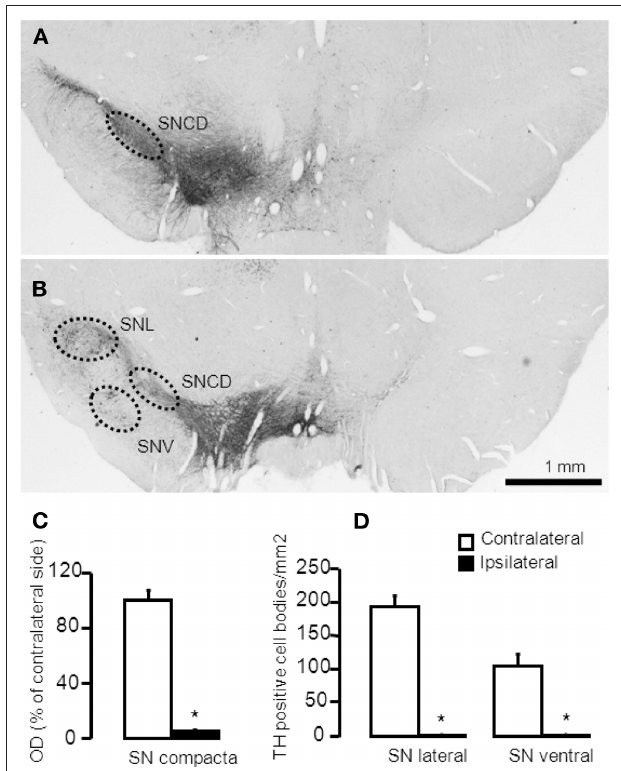
Figure 1 | representative microphotographs demonstrating TH- immunoreactive cell bodies in the substantia nigra of a rat with more than 95% cell loss. (A,B) The 6-OHDA-microinjection induced degeneration of dopamine neurons in the MFB injection side. Images were captured in sections at (A) − 5.20 mm and (B) − 6.04 mm, AP to Bregma. (C , D) Quantification of striatal TH + cells/fibers by optical density were performed at SNc ( − 5.20 mm from Bregma) and in the SNL and SNV ( − 6.04 mm from Bregma). Values are expressed as mean ± SEM (Saline-MFB, n =